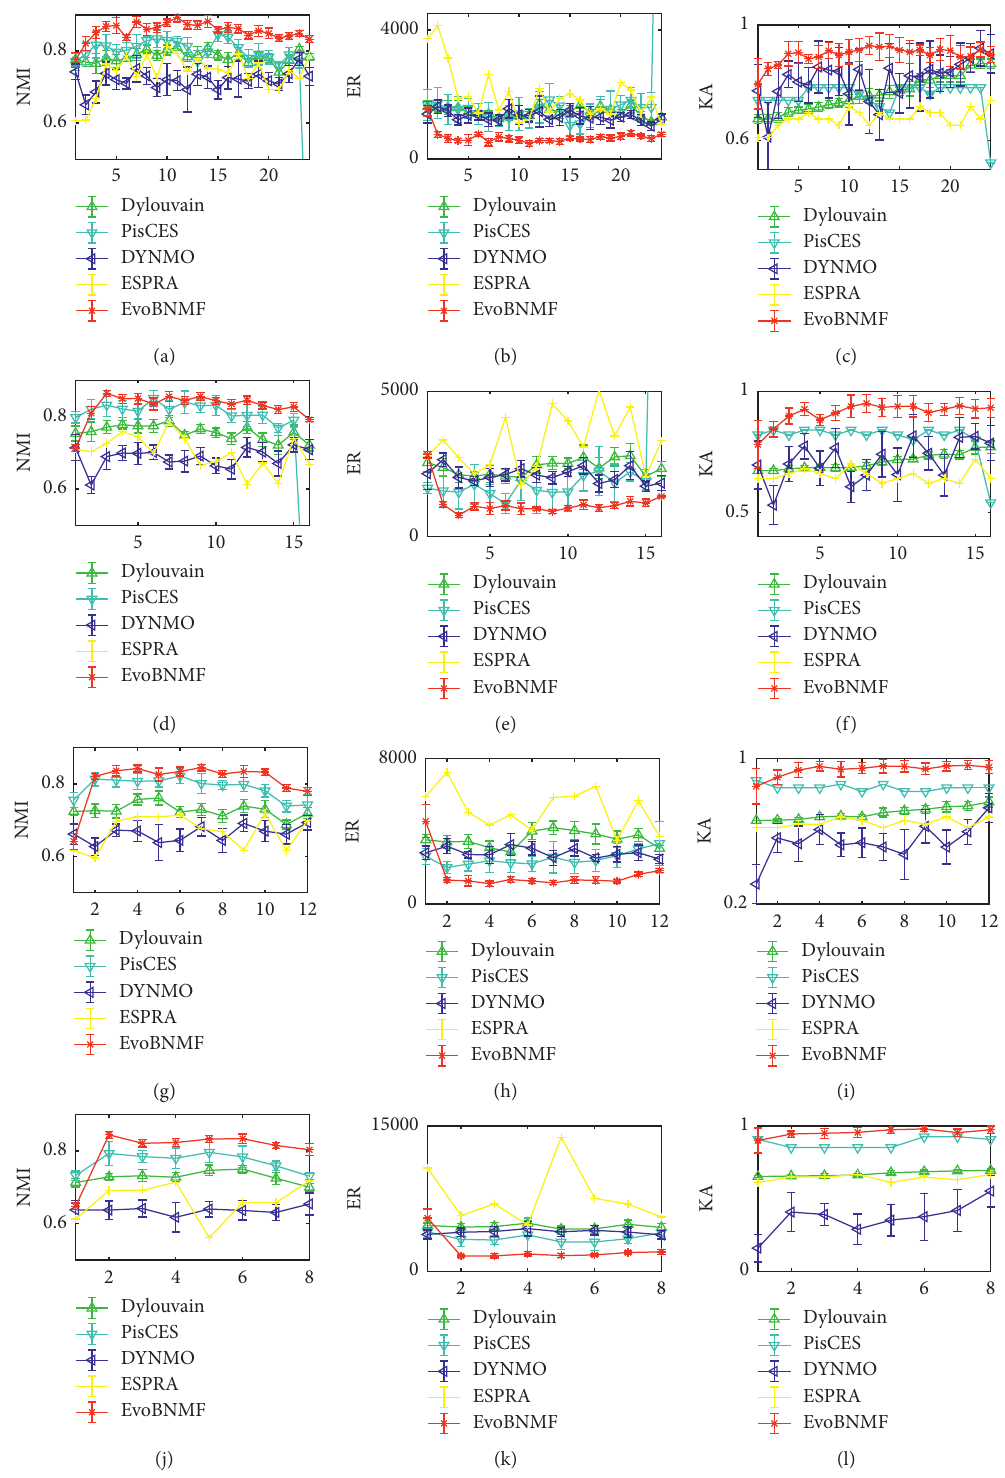
Figure 6: The comparison result of five methods on Net. 9 −